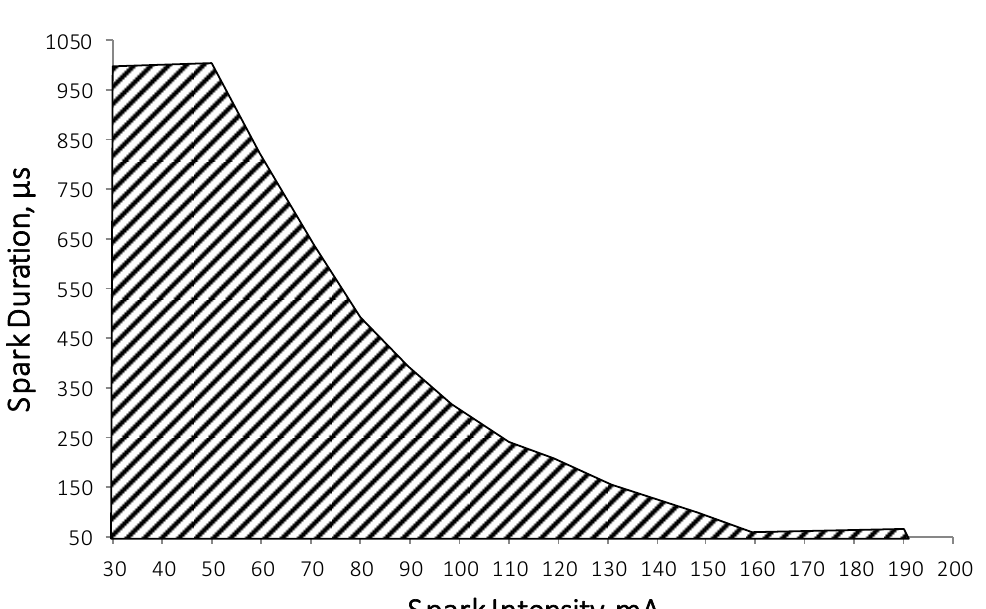
Figure 6. Target values of secondary coil-circuit current intensity and duration of the spark achievable by the ignition system.